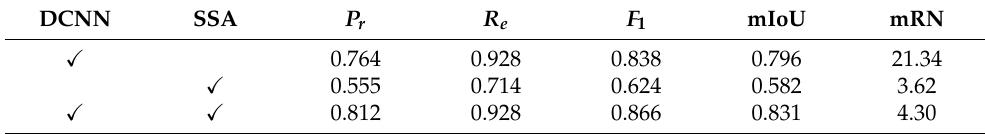
Table 5. Ablation experiment of